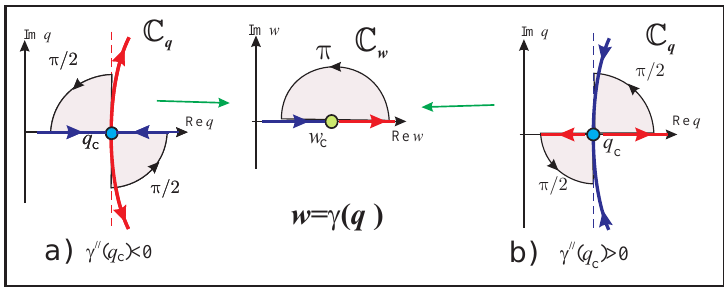
Figure 7. Projection of a complex-real characteristic function to C q near the critical point q c ; w = γ c ( q ) is the complex-real characteristic function, w c is the critical value. A few curves of the domain can intersect only at the critical point q N